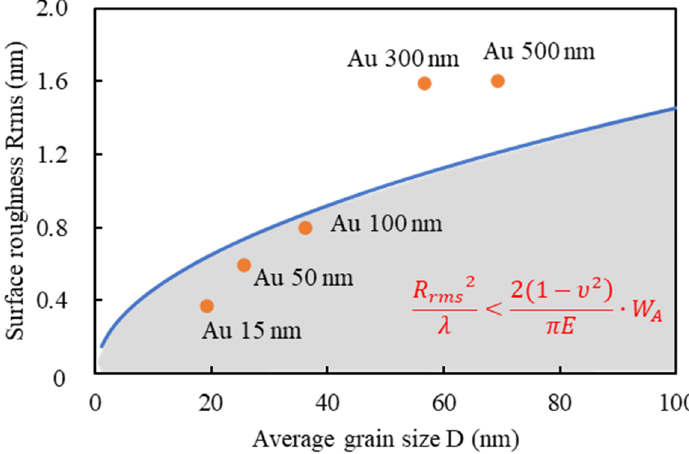
Figure 5. Relationship between surface roughness calculated using Equation (2) and average grain size. Measured average grain size and surface roughness of Au thin films with different thicknesses are also plotted.